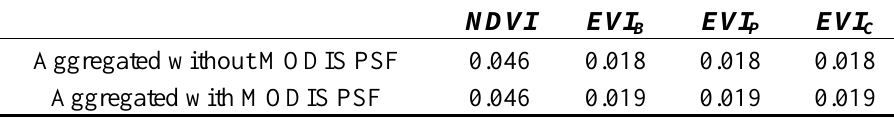
Table 2. RMSE of ASTER NDVI/EVIs against MODIS